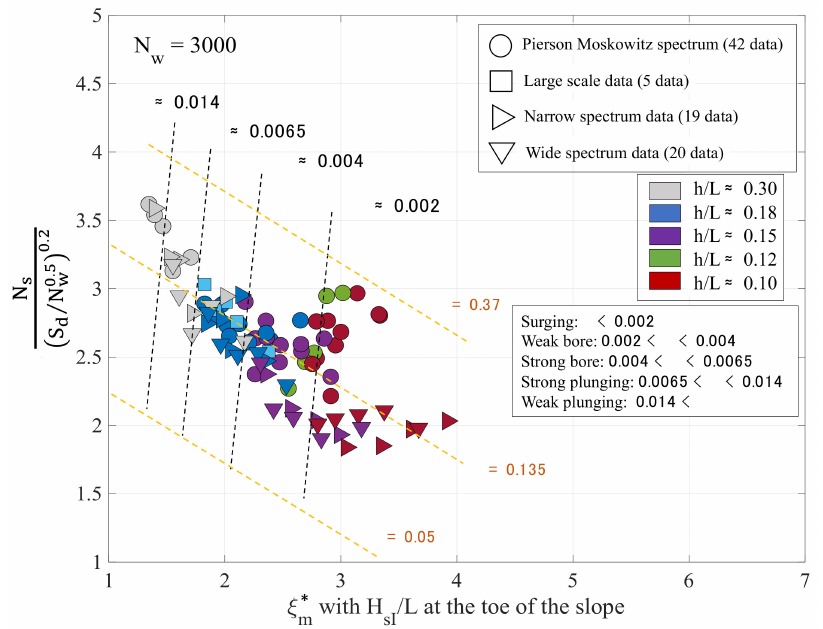
(cid:19) (cid:18) N s graph ( S ∗ ) 0.2 d